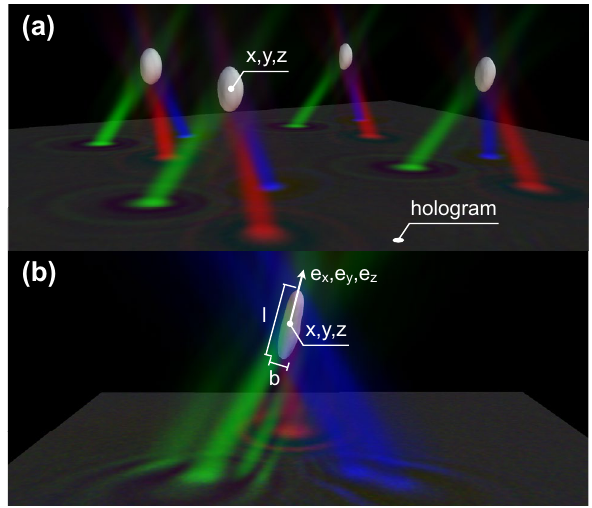
Figure 2. Holographic reconstructions of colloidal spheres and E. coli bacteria. From each color channel in a single 2D color hologram we obtain numerically the three independent scattered fields whose intensities are represented by red, green and blue density maps. An isosurface of the overlapped intensity is represented in white and closely matches the shape of simple microscopic objects such as colloidal spheres ( a ) or E. coli bacteria ( b ). Morphological analysis of these overlap regions gives information on position ( x , y , z ), size and shape ( l , b ) and orientation ( e x , e y , e z ) of the objects. This figure was made using Mayavi 27 .